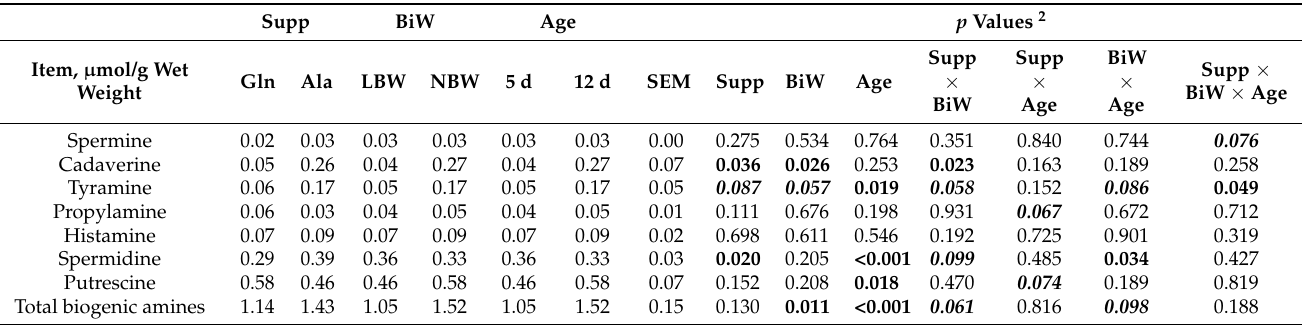
Table 2. Concentrations of biogenic amines in the colon digesta of 5- and 12-day-old male suckling piglets 1 .